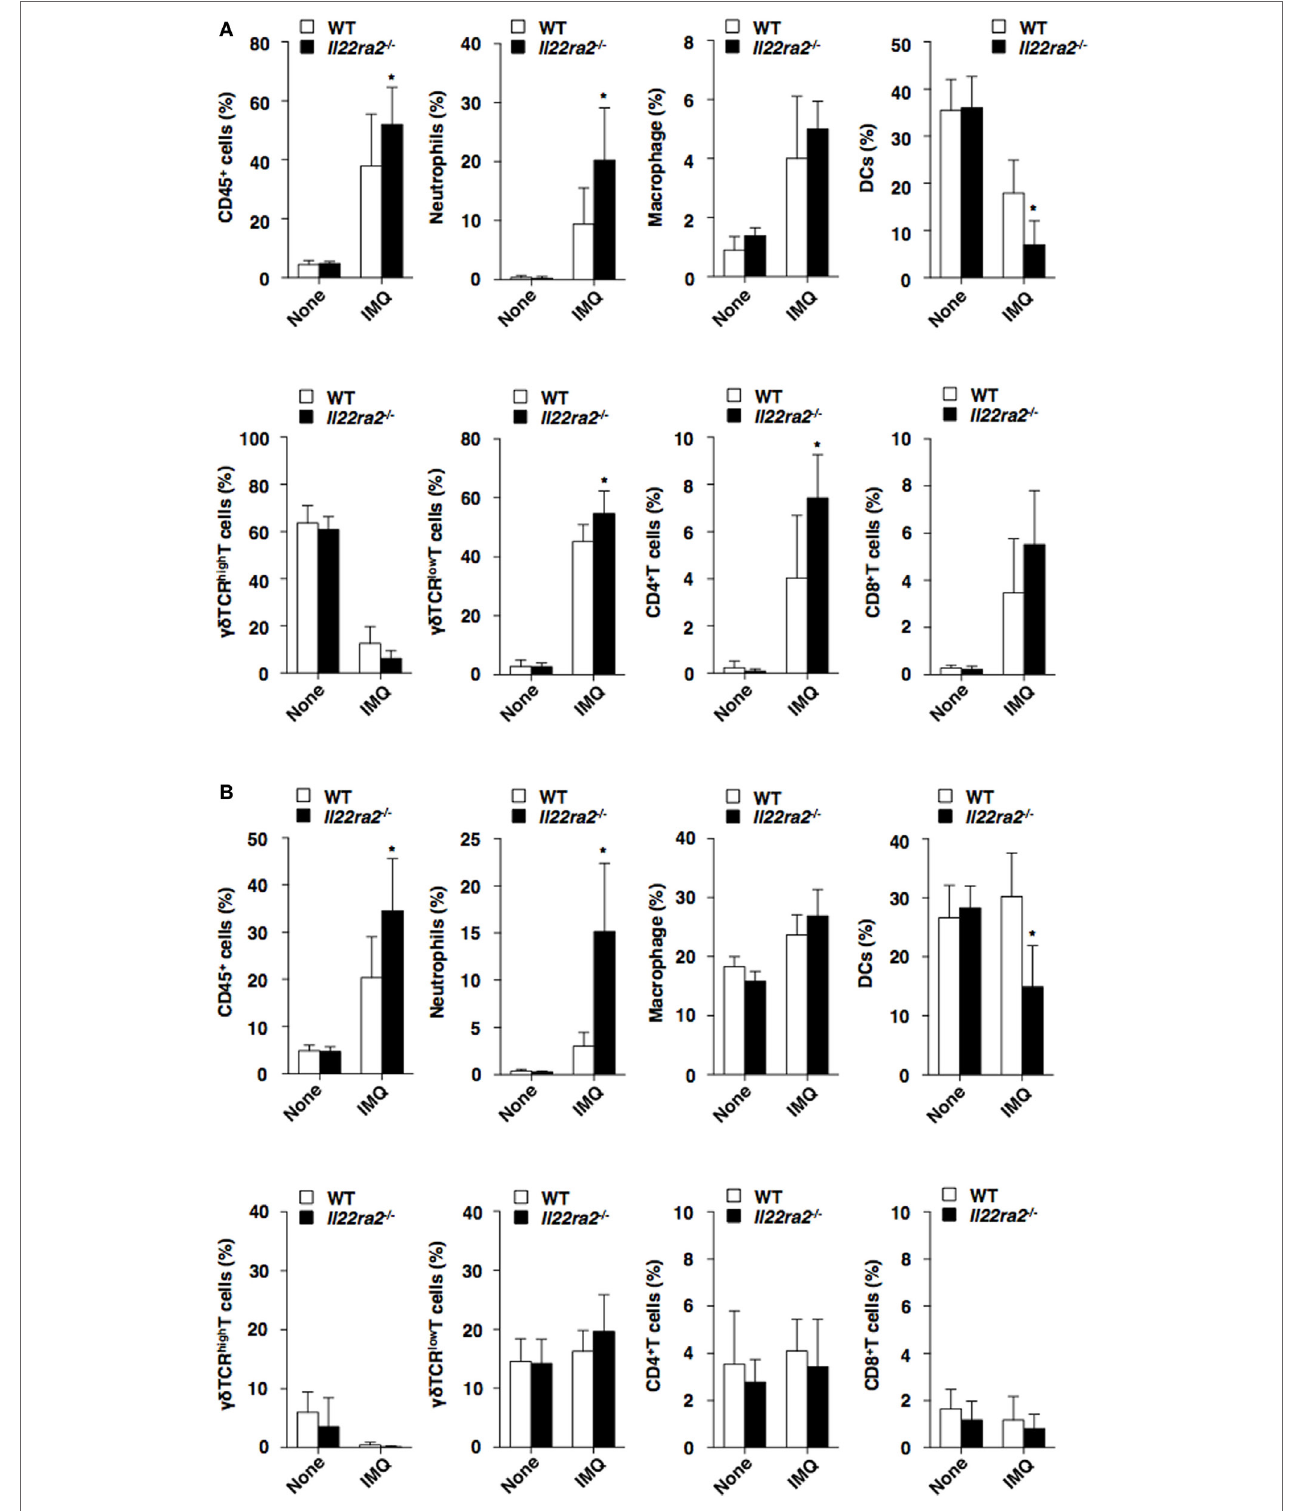
FigUre 3 | Absence of IL-22 binding protein enhances the accumulation of inflammatory leukocytes in psoriatic skin. The frequency of leukocytes in the epidermis (a) and dermis (B) was analyzed by flow cytometry at days 0 and 8 after topical application of imiquimod (IMQ) on the ear skin in wild-type (WT) mice ( n = 5) and Il22ra2 − / − mice ( n = 5). Data are the mean ± SD from three individual samples in a single experiment. * P < 0.01 compared with WT mice. All data are representative of at least three independent